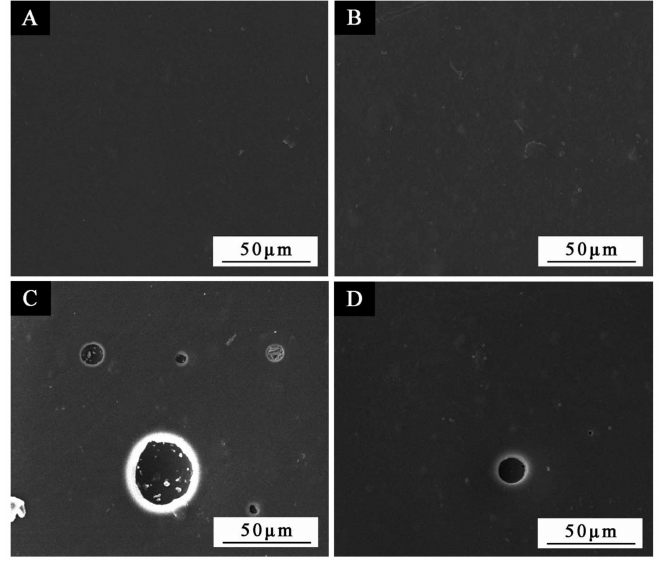
Figure 16. SEM of waterborne coating with 0% and 10.0% concentration of microcapsules (core–wall ratio is 0.58:1) before and after the aging and stability test. Before ( A ) 0%; ( B ) 10.0%; after ( C ) 0%; ( D )